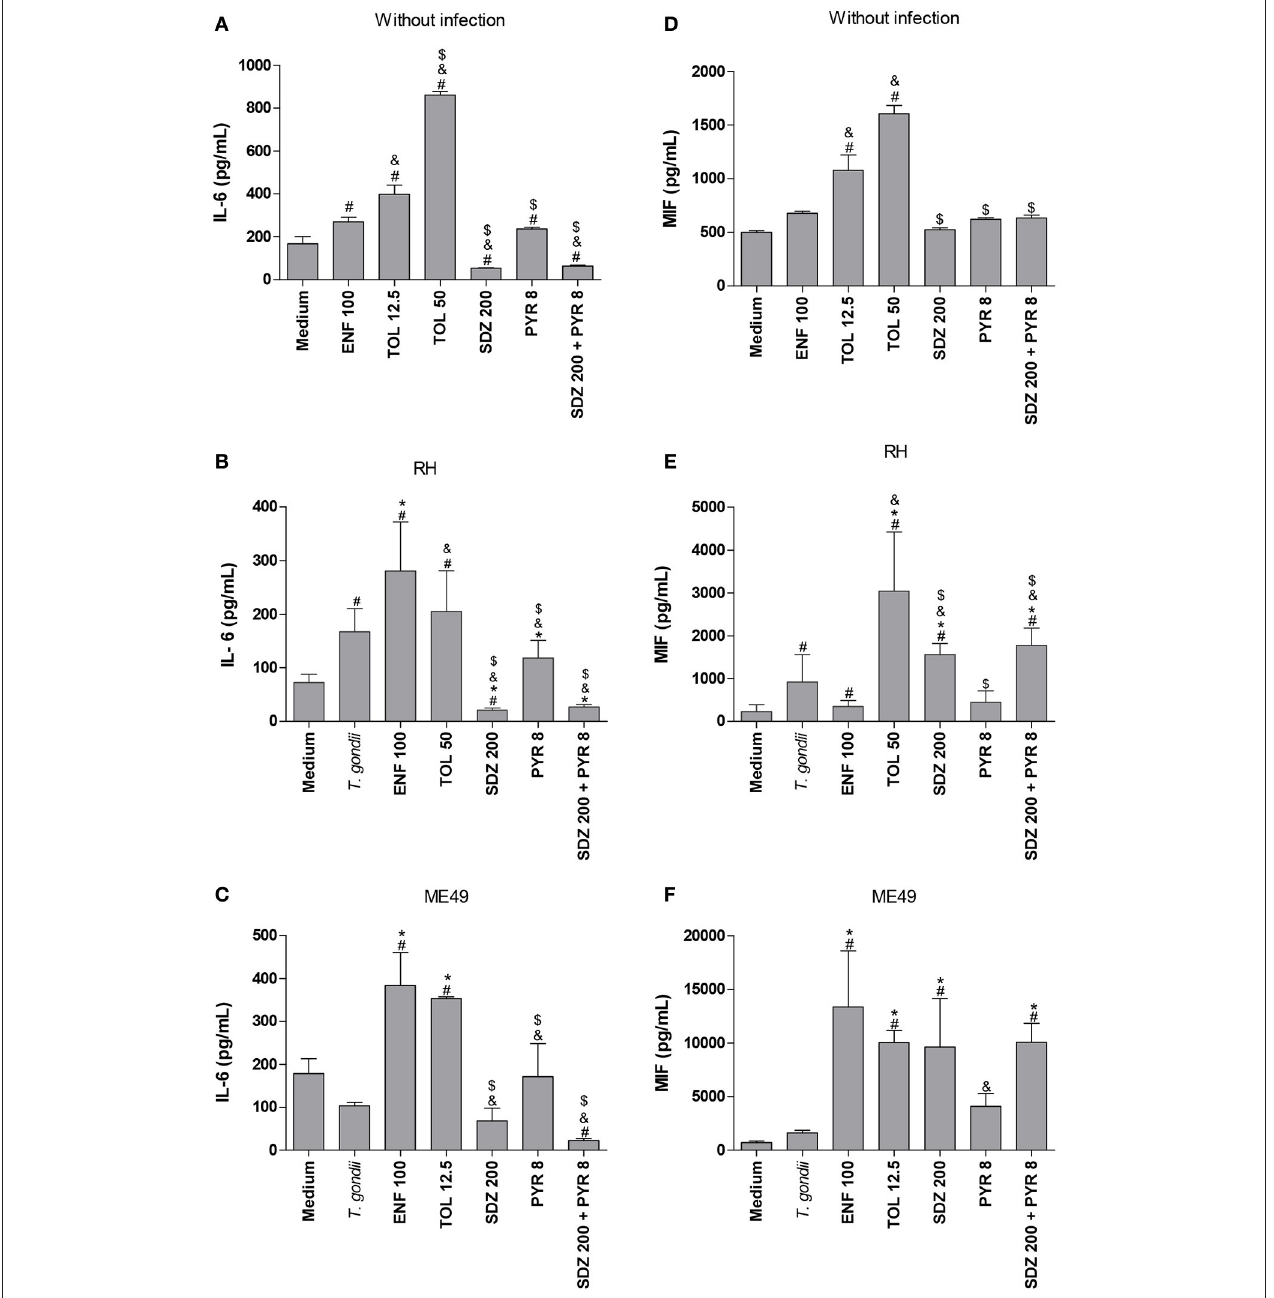
FIGURE 4 | Cytokines production in BeWo cells treated with different drugs and infected by T. gondii (RH-2F1 clone or ME49 strain). BeWo cells were maintained in culture plates for 24h, infected or not with T. gondii (RH-2F1 clone or ME49 strain) for 3 h, washed with medium to remove extracellular parasites and treated or not with the different drugs ( µ g/mL): enrofloxacin (ENF), toltrazuril (TOL), sulfadiazine (SDZ), pyrimethamine (PYR), or combination of sulfadiazine and pyrimethamine (SDZ + PYR) for additional 24h. The supernatants were collected for measurement of IL-6 (A–C) and MIF (D–F) by ELISA. Uninfected/treated cells and the respective control (medium) (A,D) or 2F1-infected/treated cells and the respective control (medium) (B,E) were cultured in 96-well plates (3 × 10 4 cells/well/200 µ L), while ME49-infected/treated cells and the respective control (medium) (C,F) were cultured in 24-well plates (1 × 10 5 cells/well/200 µ L). Data were expressed as pg/mL according to the standard curve. Data were shown as mean ± SEM from three independent experiments in nine (2F1 clone) or six replicates (ME49). Significant difference in relation to untreated and uninfected cells (medium) ( # P < 0.05), untreated and infected cells ( T. gondii ) ( ∗ P < 0.05), ENF ( & P < 0.05), and TOL ( $ P < 0.05). Differences between groups were analyzed by One-Way ANOVA with the Bonferroni multiple comparison post-hoc test.